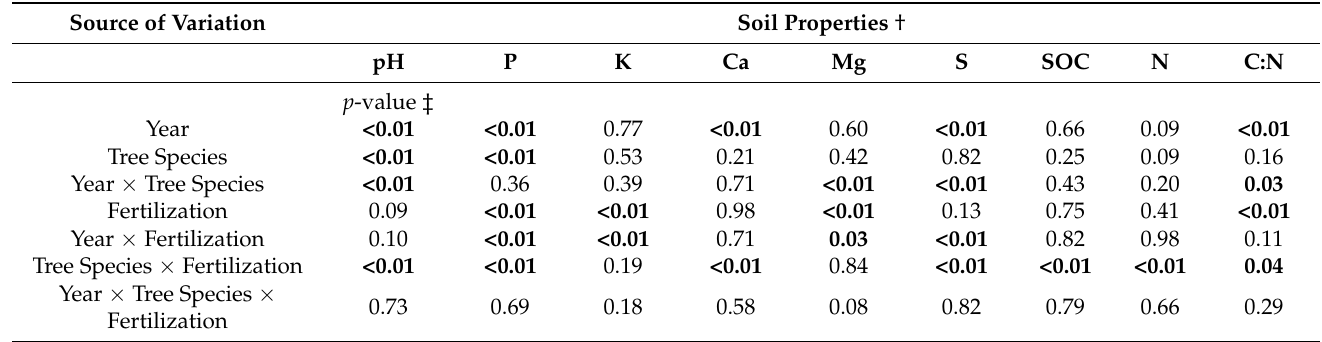
Table 1. Summary of analysis of variance of soil properties in 0–15 cm depth as affected by time (2001, 2008, and 2016), tree species, fertilization, and respective interactions in a 17-year agroforestry site in Fayetteville,